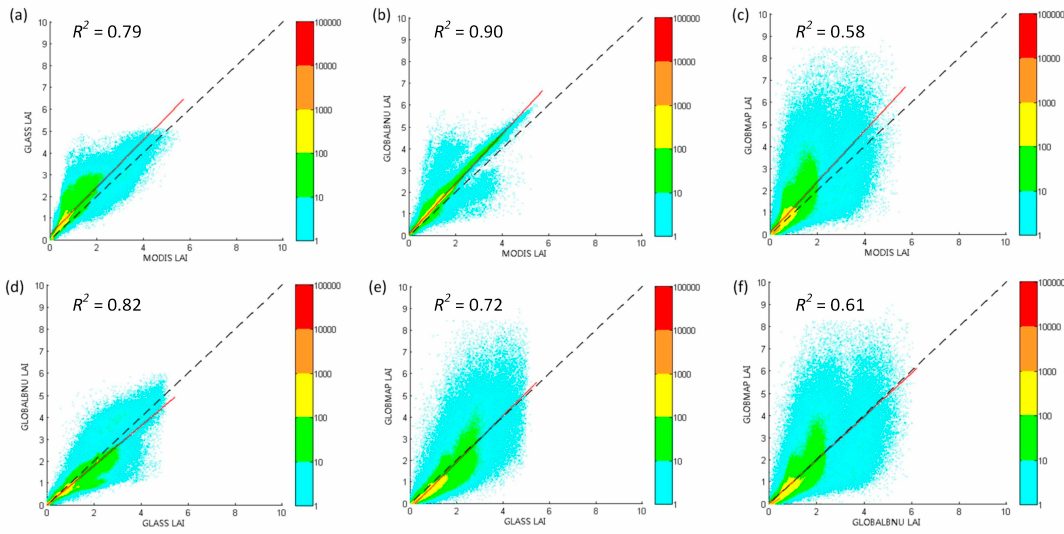
Figure 9. Density scatter plots of each pair of LAI products: ( a ) GLASS vs. MODIS; ( b ) GLOBALBNU vs. MODIS; ( c ) GLOBMAP vs. MODIS; ( d ) GLASS vs. GLOBALBNU; ( e ) GLASS vs. GLOBMAP; ( f ) GLOBALBNU vs. GLOBMAP.